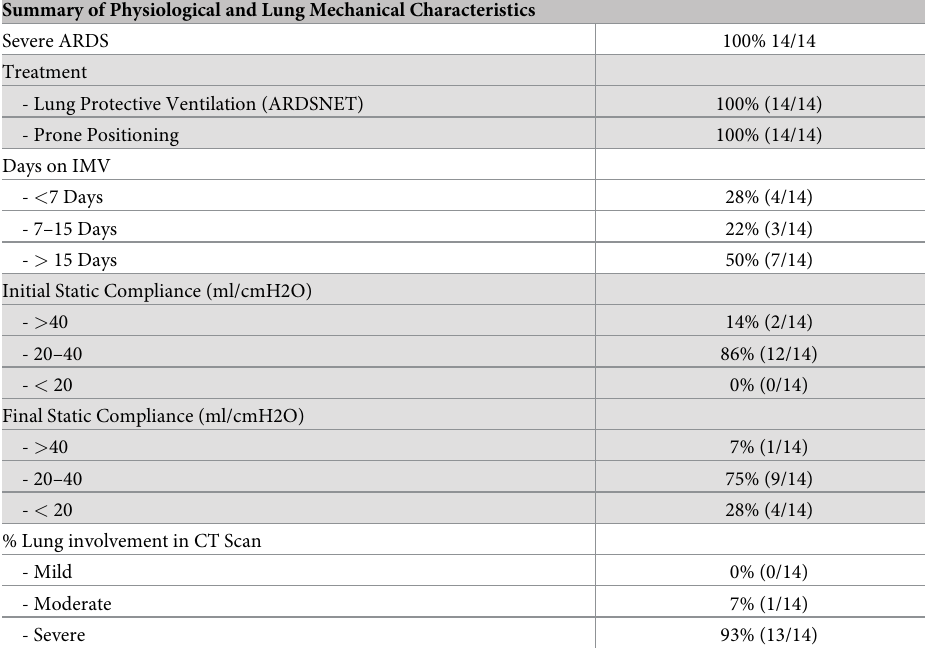
Table 4. Physiological and lung mechanical characteristics.